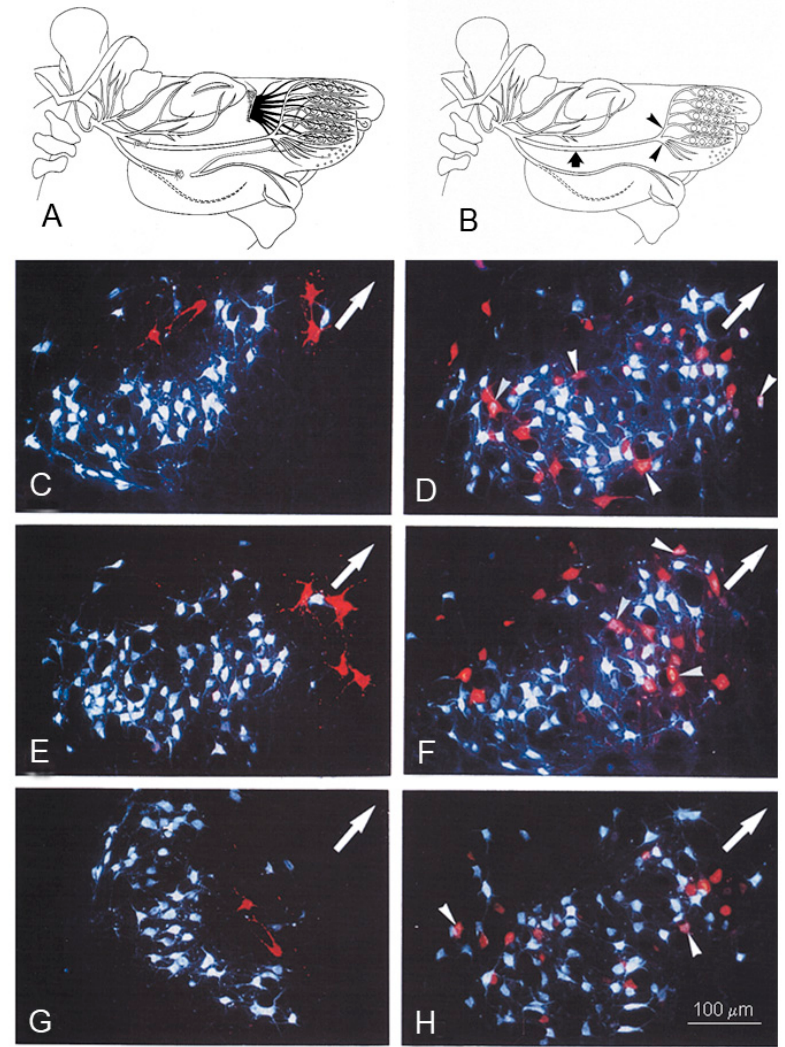
Figure 7. ( A ): Schematic drawing illustrating the transection and suture site of the buccal branch of the facial nerve (Bn-n) and the resection of Ramus marginalis mandibulae of the rat facial nerve. ( B ): The large arrow indicates the site of transection of the buccal branch. Arrowheads point at the sites of tracer application in the superior and inferior buccolabial nerves. ( C – H ): The rat brainstem 28 days after Bn-n. The photographs were produced by double exposure. The dorsomedial portion of the facial nucleus is indicated by an arrow . ( C ): The contralateral unlesioned lateral facial subnucleus with myotopic organization of the motoneurons, whose axons project into the superior buccolabial nerve [retrogradely labelled in white by Fluoro-Gold (FG)] and into the inferior buccolabial nerve (labelled in red by DiI). Most FG-labelled motoneurons are localized in the ventrolateral portion, and those labelled with DiI are in the dorsomedial part of the subnucleus. ( D ): The lesioned lateral facial subnucleus after Bn-n and application of FG to the superior, and DiI to the inferior buccolabial nerves. Note the complete lack of myotopic organization with the FG-labelled (white), DiI-labelled (red), and DiI + FG-labelled (arrowheads) motoneurons scattered throughout the entire lateral facial subnucleus. ( E ): The rat brainstem 28 days after Bn-n and excision of the ipsilateral infraorbital nerve with the contralateral unlesioned lateral facial subnucleus having myotopic organization. (F ): The lesioned facial subnucleus 28 days after Bn-n and excision of the ipsilateral infraorbital nerve. ( G ): The rat brainstem 28 days after Bn-n and excision of the contralateral infraorbital nerve. The contra- lateral unlesioned lateral facial subnucleus has the normal myotopic distribution of the motoneu- rons. ( H ): The lateral facial subnucleus 28 days after Bn-n and excision of the contralateral infraor- bital nerve; 50 µm vibratome sections. From Angelov et al. (1999) [90].